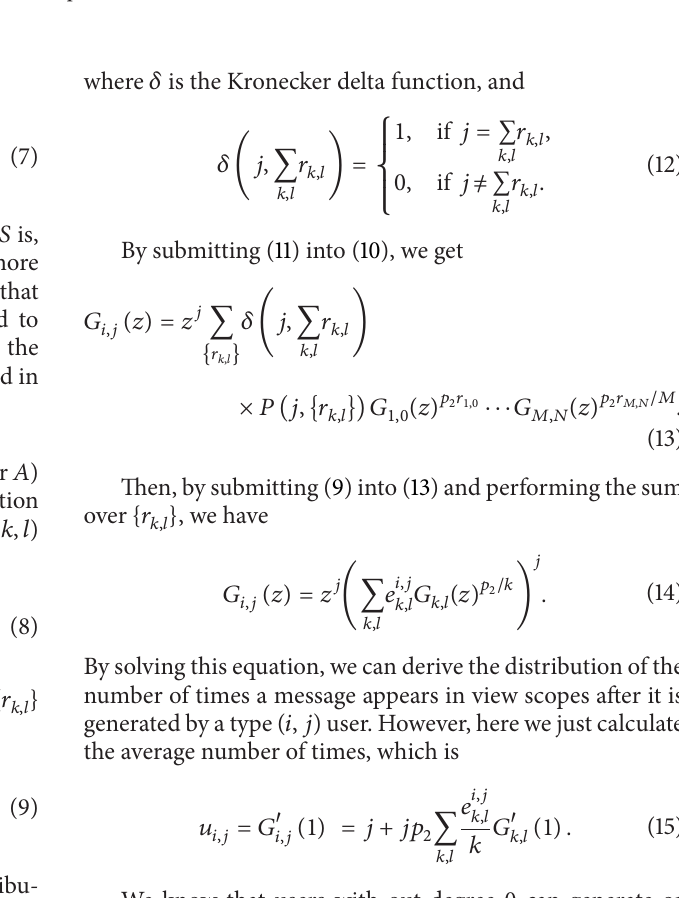
Figure 2: Evolvement of view scopes under information